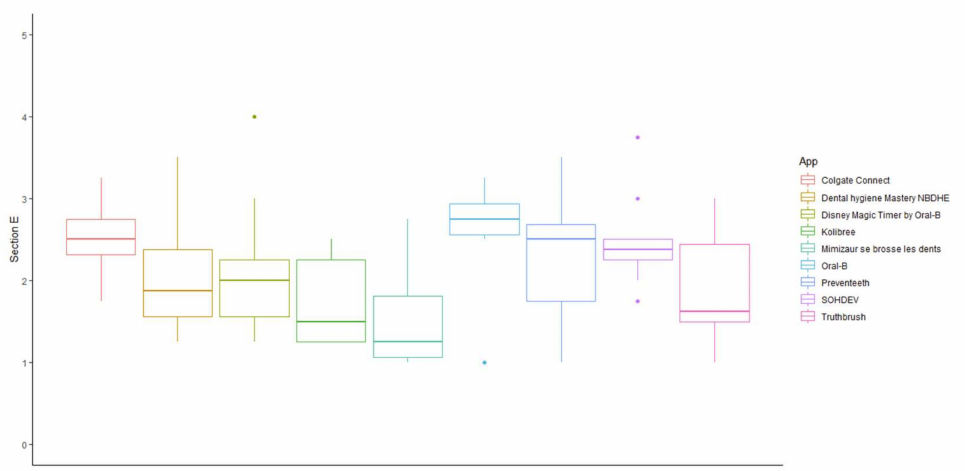
Figure 3. Subjective qualitative evaluation of oral-health-related mobile apps (section